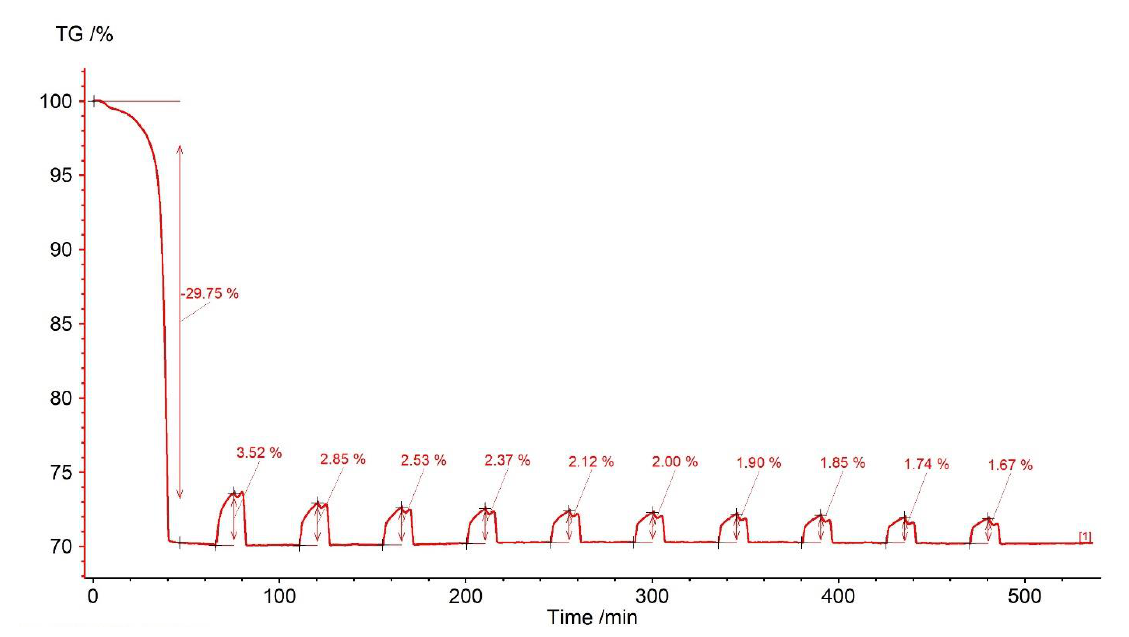
Figure 9. Relative mass changes for the marl.